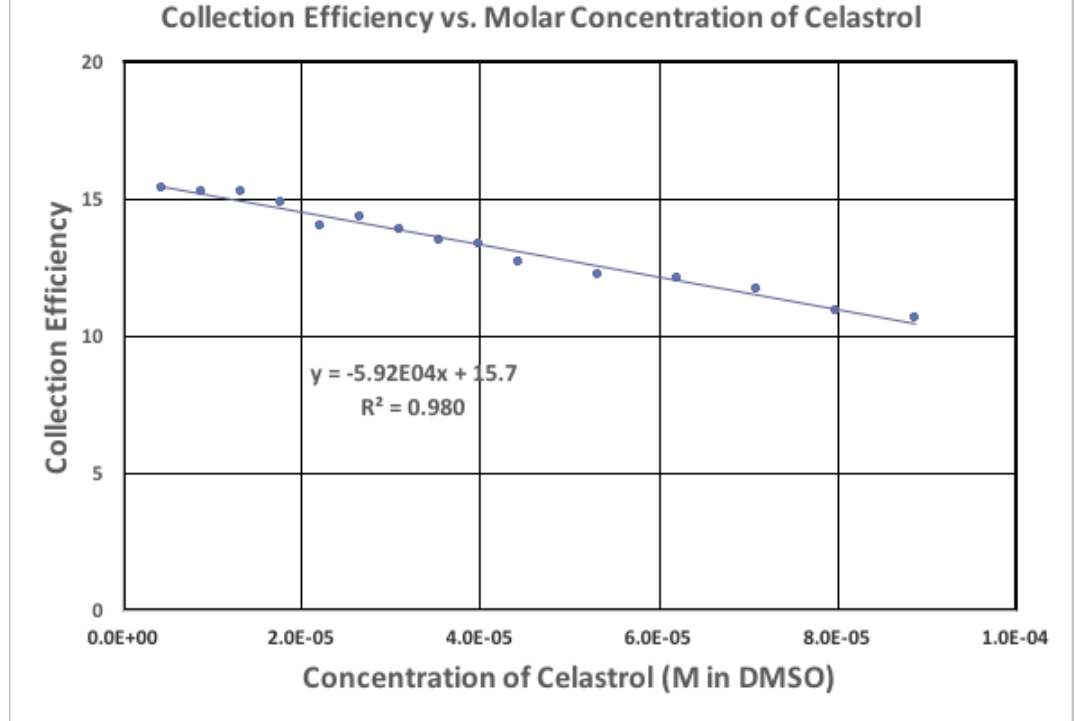
Figure 4. Rotating ring disk electrode (RRDE) voltammograms showing only 5 lines out of 15 for clarity, indicating the volume of aliquots added. The complete set of 15 data is shown in Figure 5.